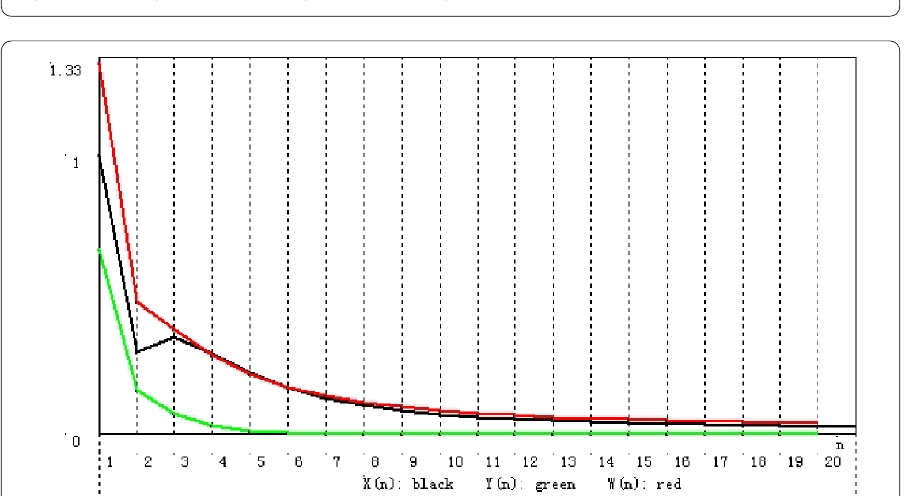
Figure 2 Convergence of { x n } and { y n } corresponding to Table 2